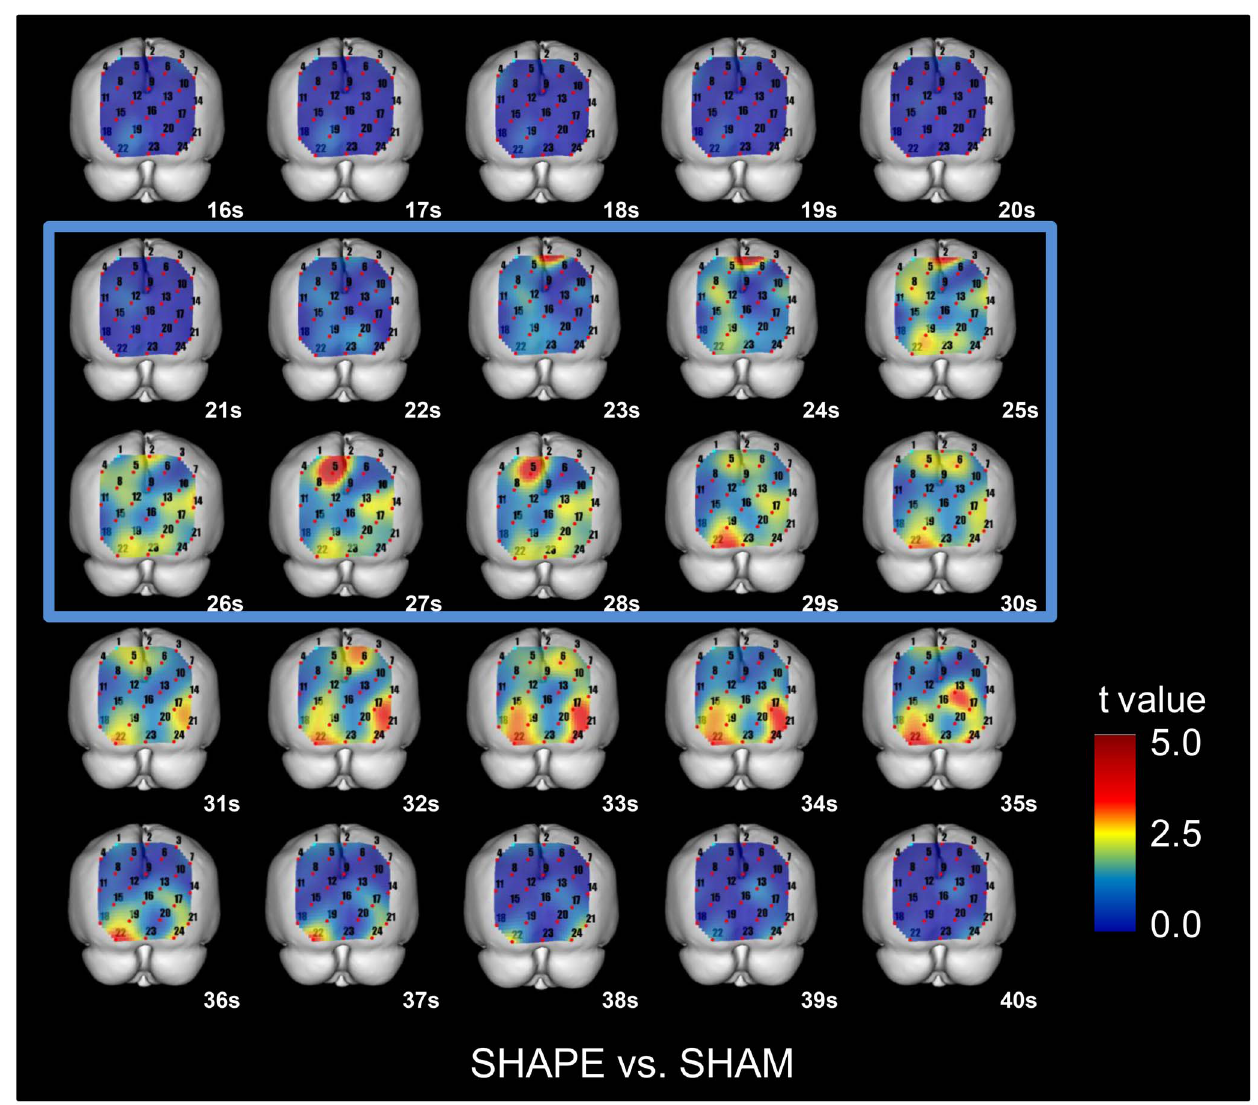
Figure 5. Cross-sectional statistical topographies showing differences in oxygenated-hemoglobin concentrations ([oxy-Hb]) between SHAPE and SHAM sessions. The values for [oxy-Hb] during the task period of the SHAPE session were significantly increased (p , 0.05, paired t-test) as compared to the SHAM session in the posterior parietal cortex (BA7), extrastriate cortex (BA18, 19), and striate cortex (BA17).